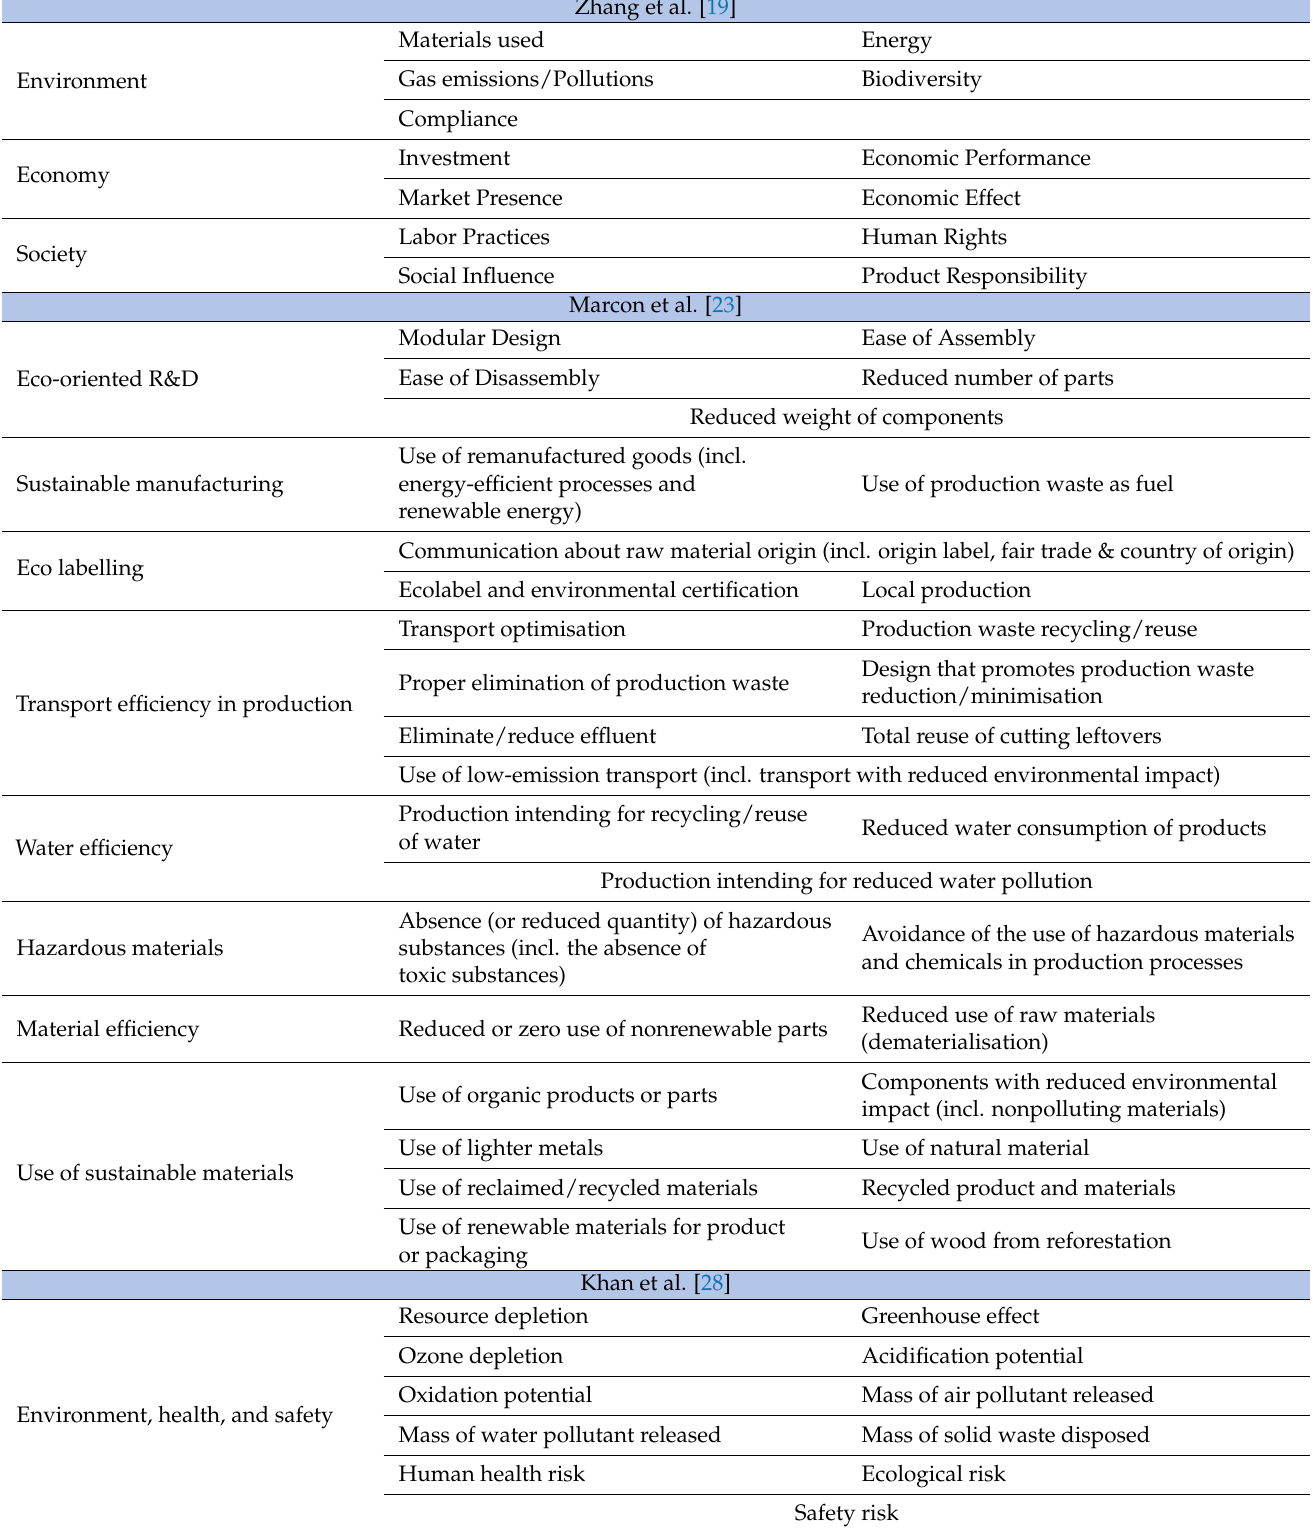
Table 1. List of relevant indicators; own